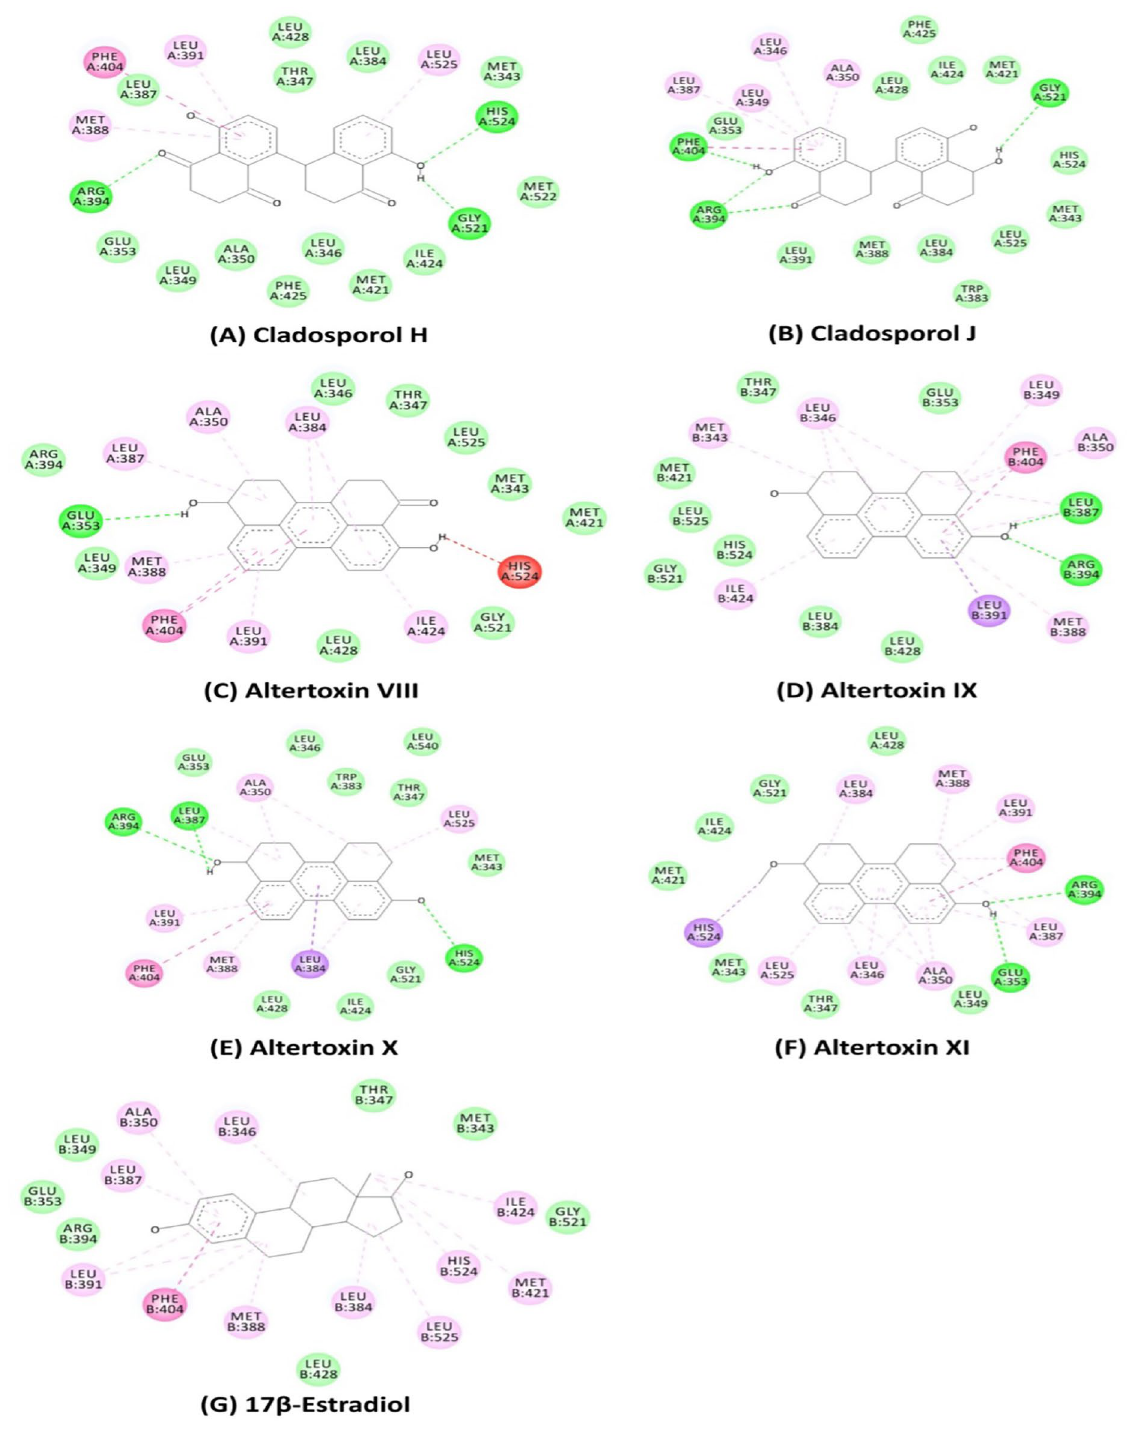
Figure 2. Non-bonding interaction of the potential bioactive compounds extracted from Cladosporium spp. against estrogen receptor alpha (PDB: 6CBZ)